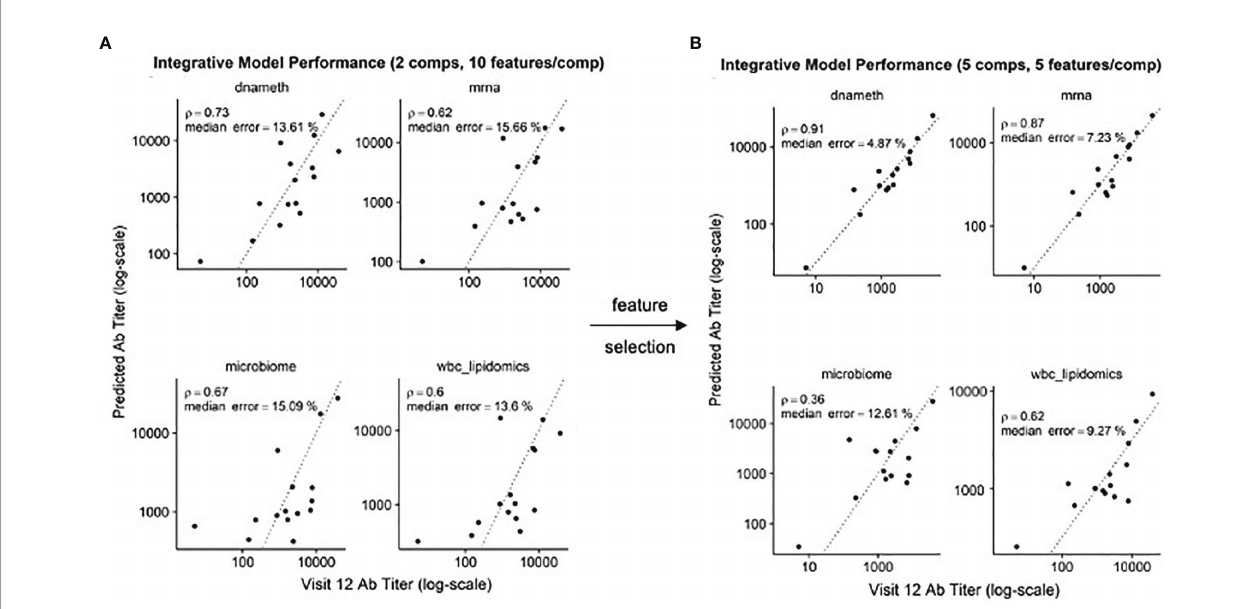
FIGURE 6 | Improved correlation of Diablo models with serum antibody (Ab) responses to HBV vaccination – Actual Ab titers at Visit 12 (after third dose) (x-axis) vs . predicted Ab titers (y-axis) in models derived from different assay platforms are visualized. Dotted line is the identity line representing perfect prediction. Rho is Spearman ’ s rank correlation when comparing actual Ab titers to predicted Ab titers. (A) Optimal Diablo models were produced using 2 components and 10 features/ component and all available assay variables. (B) Optimal Diablo models were produced using 5 components and 5 features/component and only selected variables related to 735 dendritic cell TLR3-response genes in the DNA methylation (dnameth) and bulk transcriptomic (mrna) data. CpG sites were assigned to dendritic cell TLR3-response genes as described previously (38, 39). Note that although the microbiome and wbc-lipidomics data are identical in the two sets, the models they produce (features retained and their coef fi cients) in the generalized canonical correlation framework are different due to different correlation characteristics with the different dnameth and mrna models. In both cases, the number of components and number of features/component were selected to maximize model